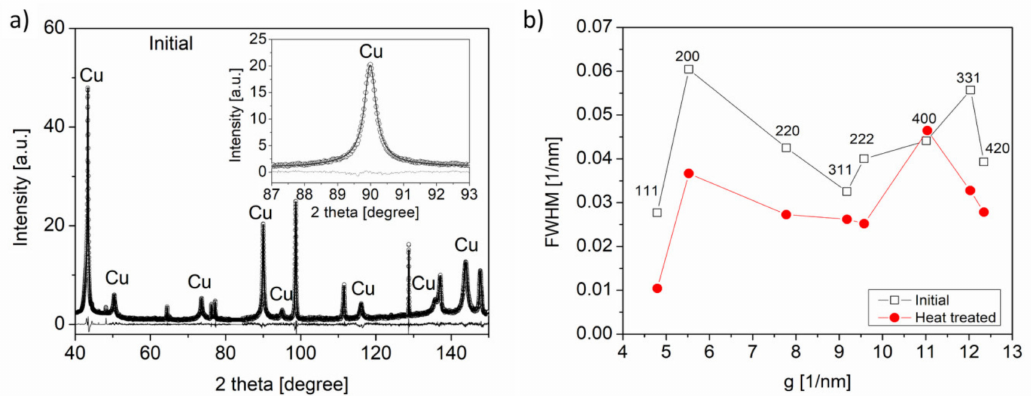
Figure 5. ( a ) Convolutional multiple whole profile (CMWP) fitting on the XRD pattern of the initial foam. The measured and the calculated di ff ractograms are represented by open circles and solid line, respectively. At the bottom of the figure, the di ff erence between the measured and the calculated patterns is also shown. For the visualization of the fit quality, a magnified part of the di ff ractogram is shown in the inset. ( b ) Williamson-Hall plots for the initial and the heat-treated